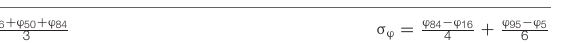
TABLE 1 | Formulae used to calculate the main granulometric parameters, according to Folk and Ward graphical measures (Folk and Ward, 1957), where M ϕ is the estimated mean grain size and σ ϕ is the estimated standard deviation of the sample in phi units.